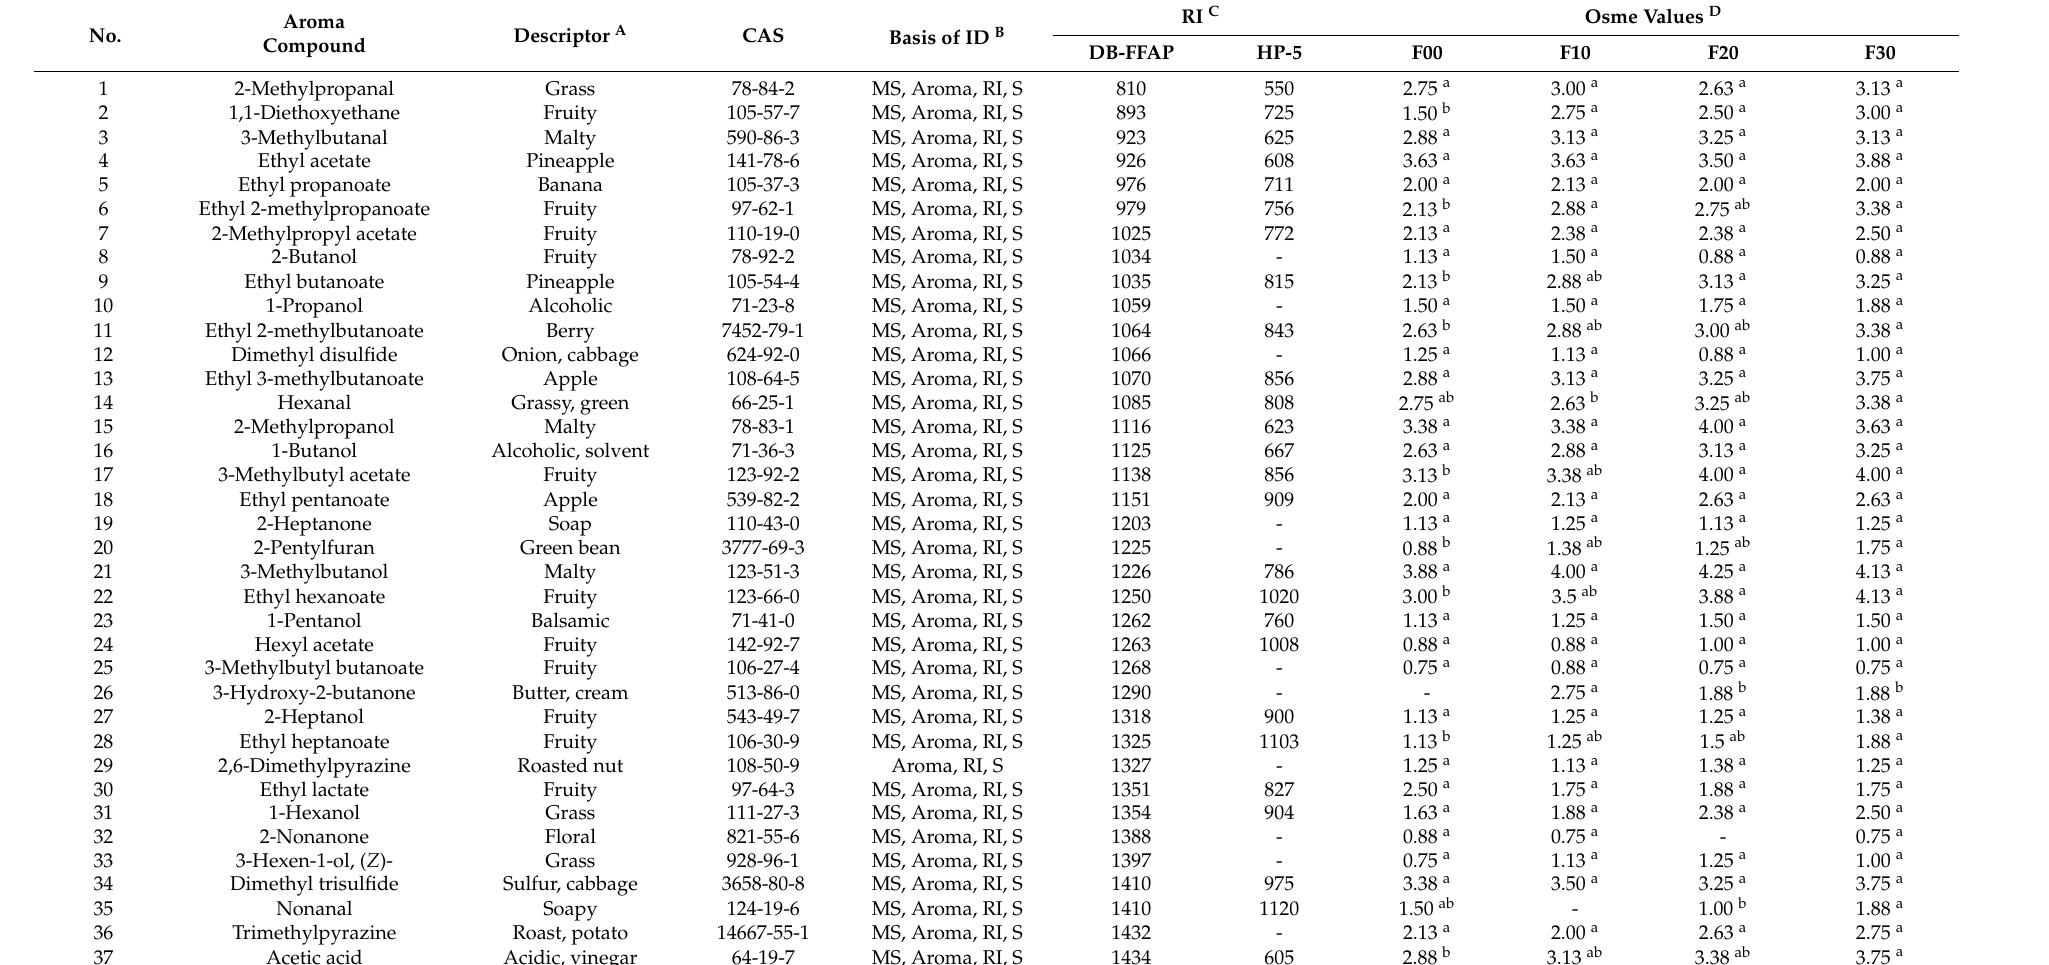
Table 1. Aroma compounds identified by GC-O-MS in four different grades of